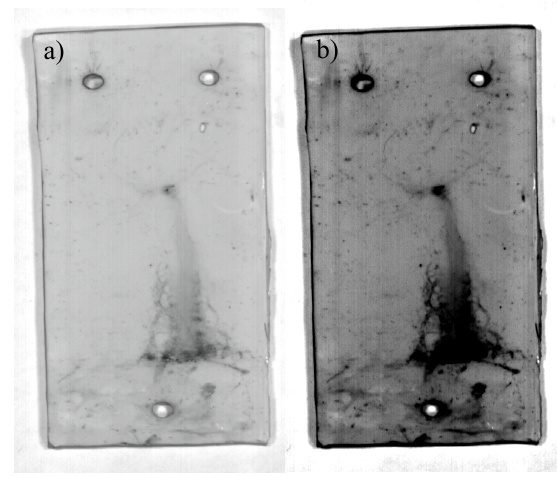
Figure 10. RTV-2 +22% ATH (aluminum trihydrate) sample after 30 min of dry-band arcing ( a ) and Figure 10. RTV-2 + 22% ATH (aluminum trihydrate) sample after 30 min of dry-band arcing ( a ) and hyperspectral false color image showing damage ( b ). hyperspectral false color image showing damage ( b ).